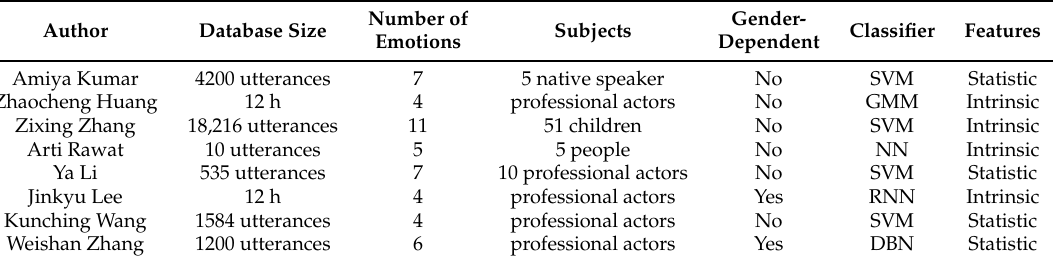
Table 5. Summary of related